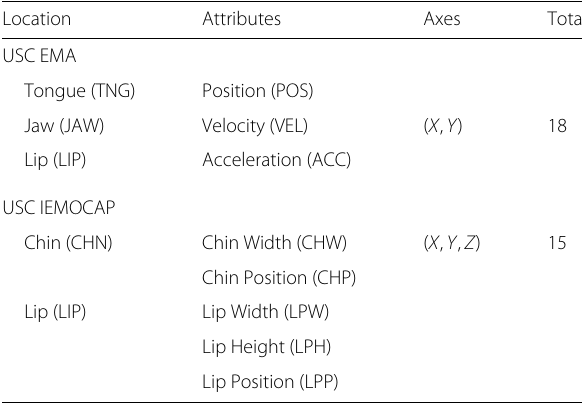
Table 1 Articulatory targets for the USC EMA and USC IEMOCAP